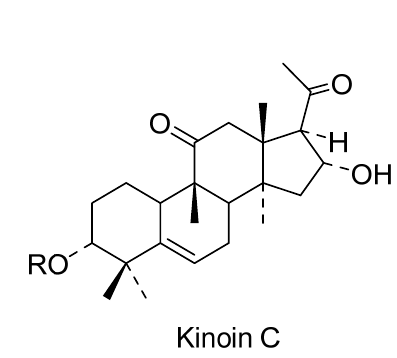
Figure 7. Molecules of the type of the cucurbitan series isolated from I. sonorae .